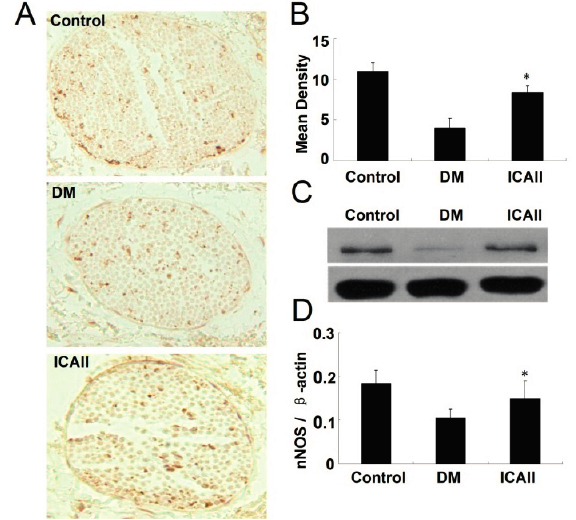
Figure 3. ICA II enhances the nNOS expression in diabetic rat corpus cavernosum. ( A ) Immunohistochemical staining with antibody to nNOS in dorsal nerve bundle of normal and diabetic rat; ( B ) Semiquantitative analysis of nNOS protein expression; ( C ) Western blots analysis of the nNOS expression in normal and diabetic rat corpus cavernosum; ( D ) The ratio of nNOS to β -actin by Western blot. Each bar depicts the mean values (±standard deviation) from N = 10 (immunohistochemical staining) and N = 4 (Western blots) animals per group. * p < 0.01 in the ICA II-treated group compared with the DM placebo